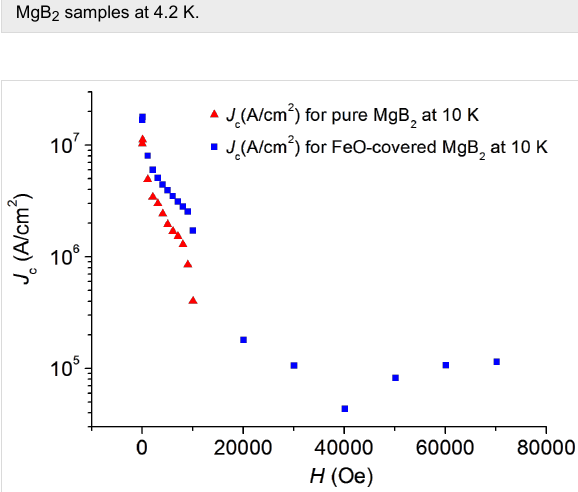
Figure 1: Magnetization hysteresis ( M–H ) curves for the pure MgB 2 sample at various temperatures: 4.2 K, 10 K, 15 K, and 20 K.